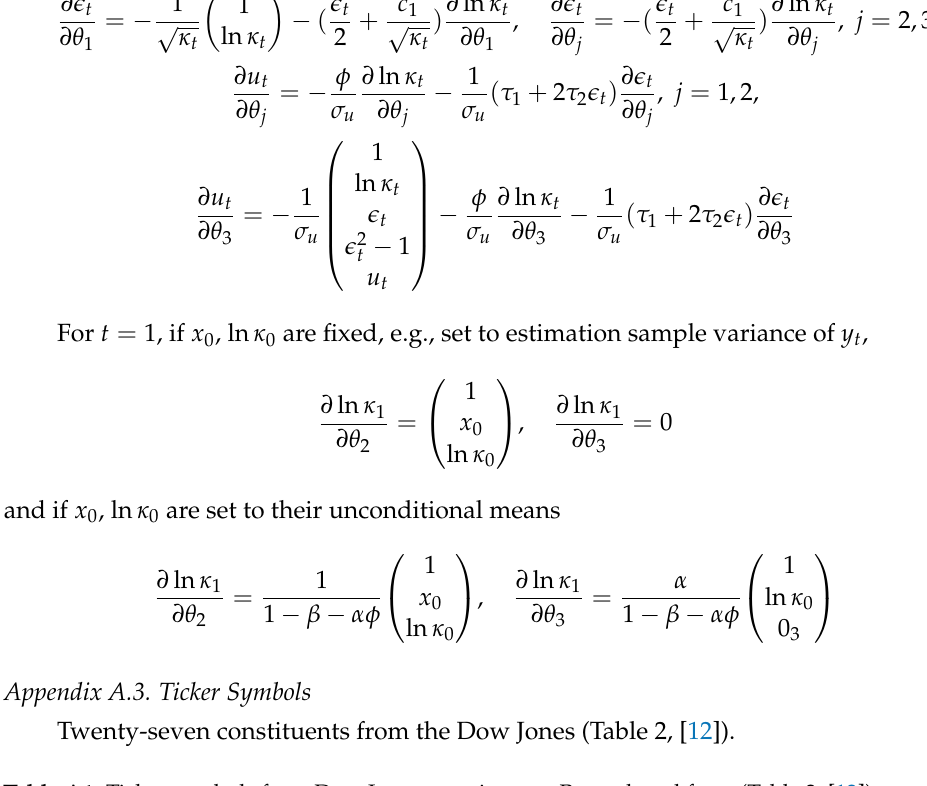
Table A1. Ticker symbols from Dow Jones constituents. Reproduced from (Table 2,